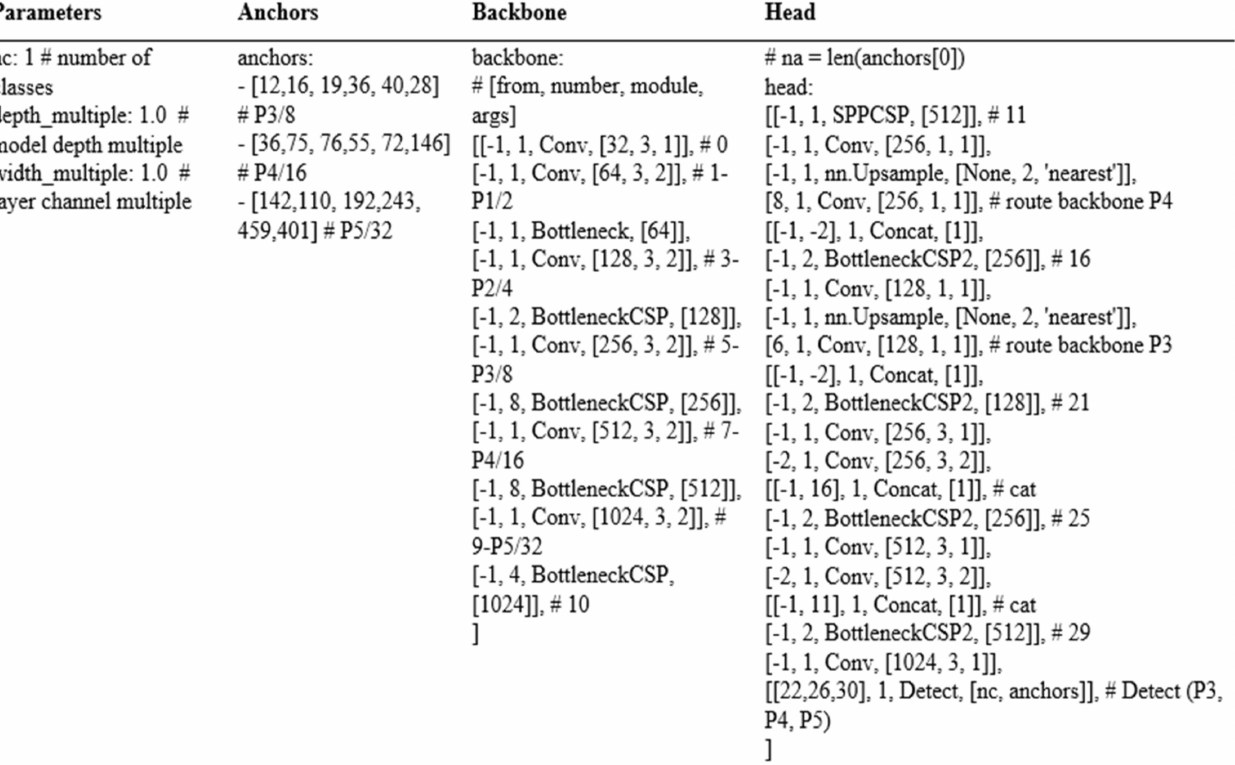
Figure 6. Architectural configuration of CSP-ized